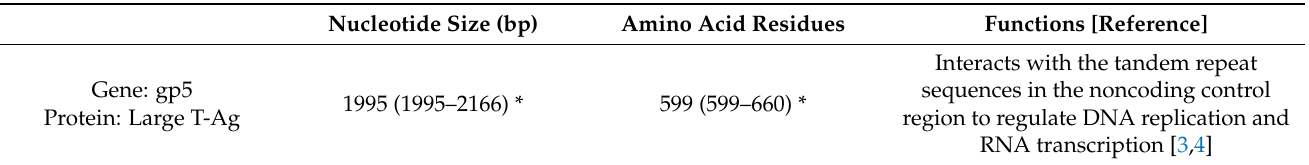
Figure 1. A genomic structure of avian polyomavirus using budgerigar fledgling disease virus as a typical example. In general, all polyomaviruses containing 5–6 open reading frames (ORFs) are composed of an early coding region, which encodes the large T-Ag (colored in gray) and small T-Ag (yellow), and a late region, which encodes structural proteins VP1 (blue), VP2 (green), and VP3 (violet). The VP4 (red) in the genome of the budgerigar fledgling disease virus is not always present in APVs. Some APVs (e.g., butcherbird polyomavirus, cormorant polyomavirus, crow polyomavirus, Erythrura gouldiae polyomavirus, finch polyomavirus, goose hemorrhagic polyomavirus, and Hungarian finch polyomavirus) have a putative VP4 or ORF-X protein. The key biological role of each gene is given in Table 1. Table 1. Name of the genes with respect to their nucleotide size, amino acid residues, and functions of Avian